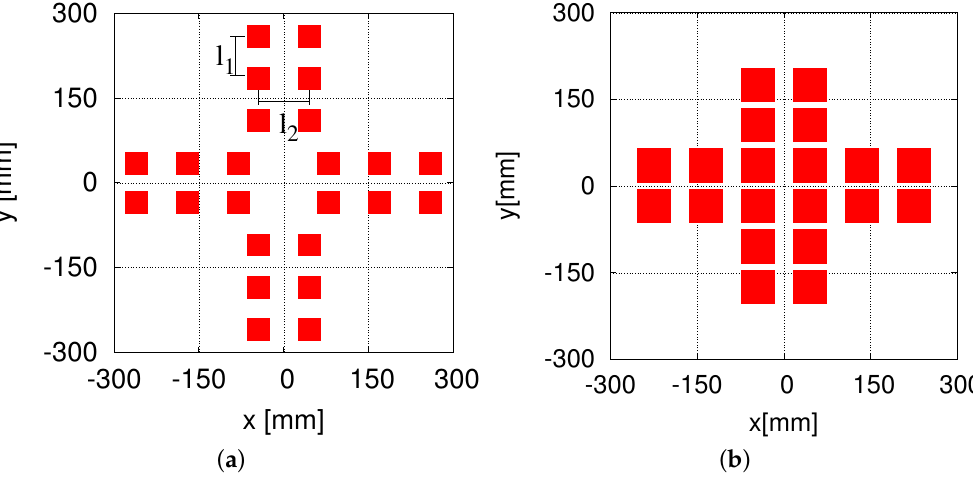
Figure 5. Arrangements of the 24 and 20 RFID readers. ( a ) the 24 readers; ( b ) the 20